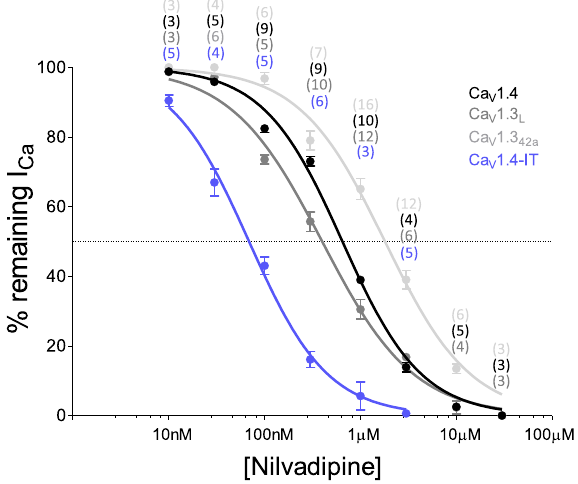
Figure 7. Concentration–response curves for calcium current inhibition by nilvadipine. In the nilvadipine dose–response curve the percentage of the remaining calcium current in the presence of different nilvadipine concentrations is indicated for human Ca V 1.4-WT (black), Ca V 1.4-IT (blue), Ca V 1.3 L (dark grey) and Ca V 1.3 42a (light grey) channels. The dotted line indicates how the IC 50 was determined. All data points represent mean ± SEM; the number of cells recorded is indicated in the graphs.